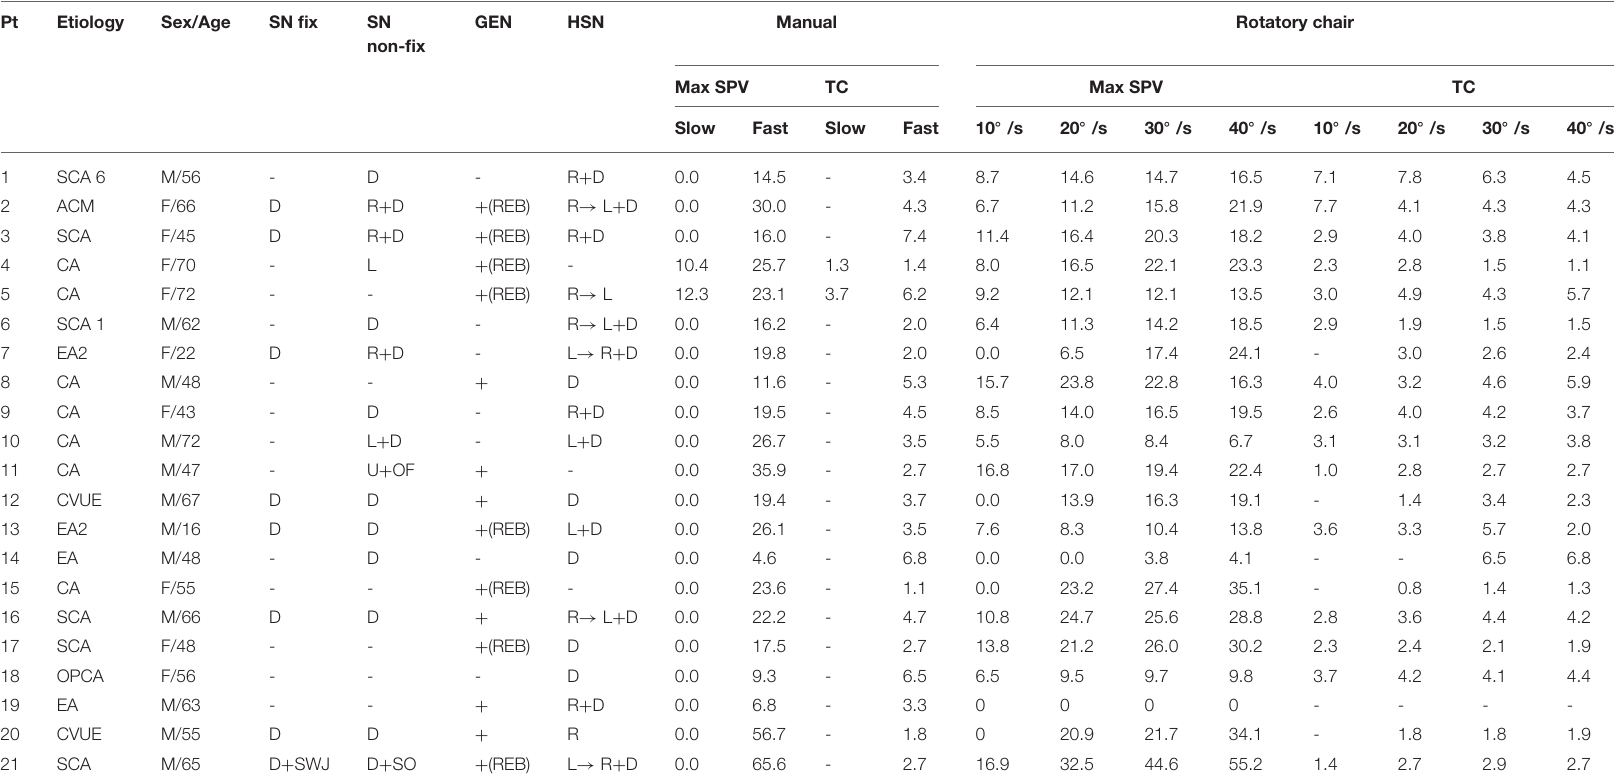
TABLE 1 | Findings in patients with paroxysmal downbeat central positional